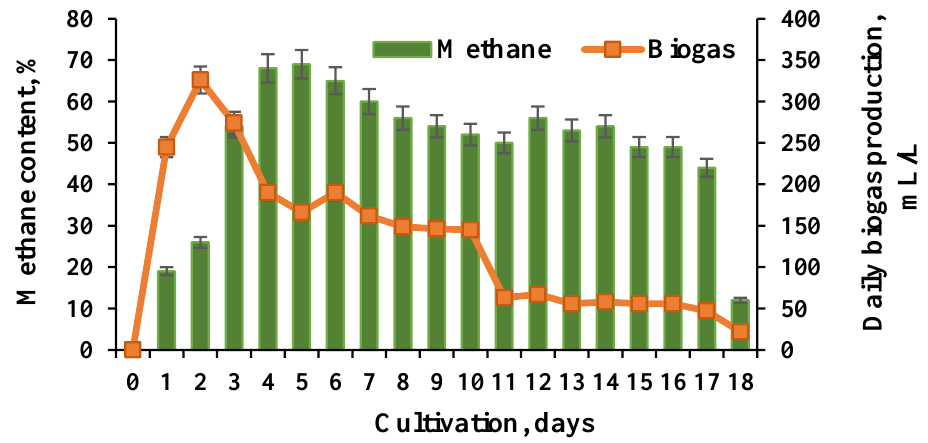
Figure 2. Biomethane production in BR2 of the cascade. The pH in the second BR was maintained in the range of 5.5 to 7.0 during the whole process. For comparison, performing the process with the same substrate, pretreatment, and loading in a single-stage system realized the highest methane value of 58% (Figure 3).